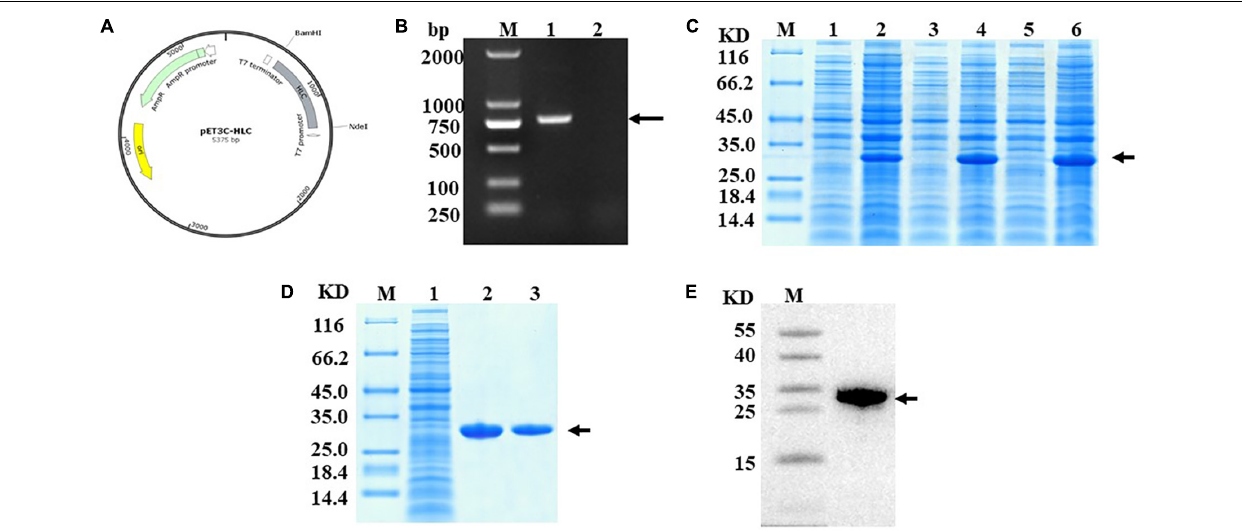
FIGURE 1 | Construction and identification of RHC. (A) Construction schematic of the recombinant pET3c-hlcollagen plasmid. (B) Nucleic acid electrophoresis of recombinant plasmid pET3C-HLC. M: DNA Ladder 2000; lane 1: monoclone of recombinant plasmid pET3C-HLC; lane 2: negative control. (C) Effect of temperature on RHC expression, as analyzed by SDS-PAGE. Recombinant human-like collagen was induced by IPTG for 4 h at either 37 or 30 ◦ C or overnight at 20 ◦ C. M: middle molecular weight protein markers; lanes 2, 4, and 6: RHC after induction at 20, 30, or 37 ◦ C; lanes 1, 3, and 5: RHC before induction. (D) Sodium dodecyl sulfate–PAGE analysis of proteins during purification. M: middle molecular weight protein markers; lane 1: broken by PBS; lane 2: Ni-NTA spin columns; lane 3: washed protein through 80 mM imidazole. (E) Western blotting analysis. M: middle molecular weight protein markers; lane 1: RHC with an anti-His antibody.